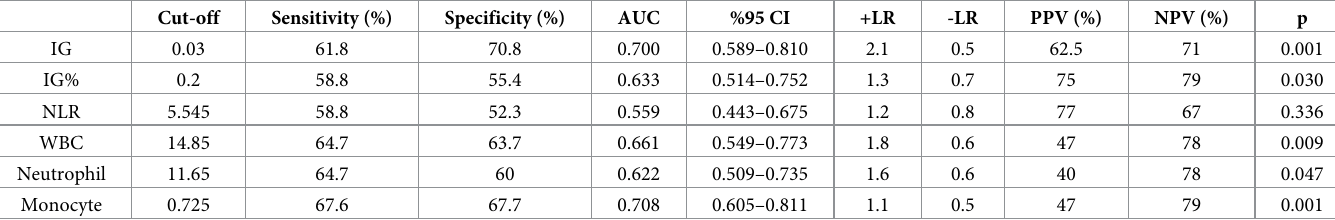
Table 5. Predictive evaluation of the best parameters to show complication of disease.